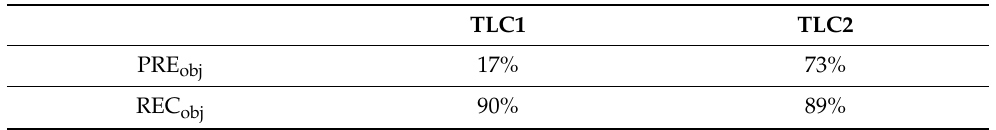
Table 3. Global object detection performance of SSD ret for each camera by considering all the grids and priors as defined in Table 1. Precision: PRE obj ; Recall: REC obj